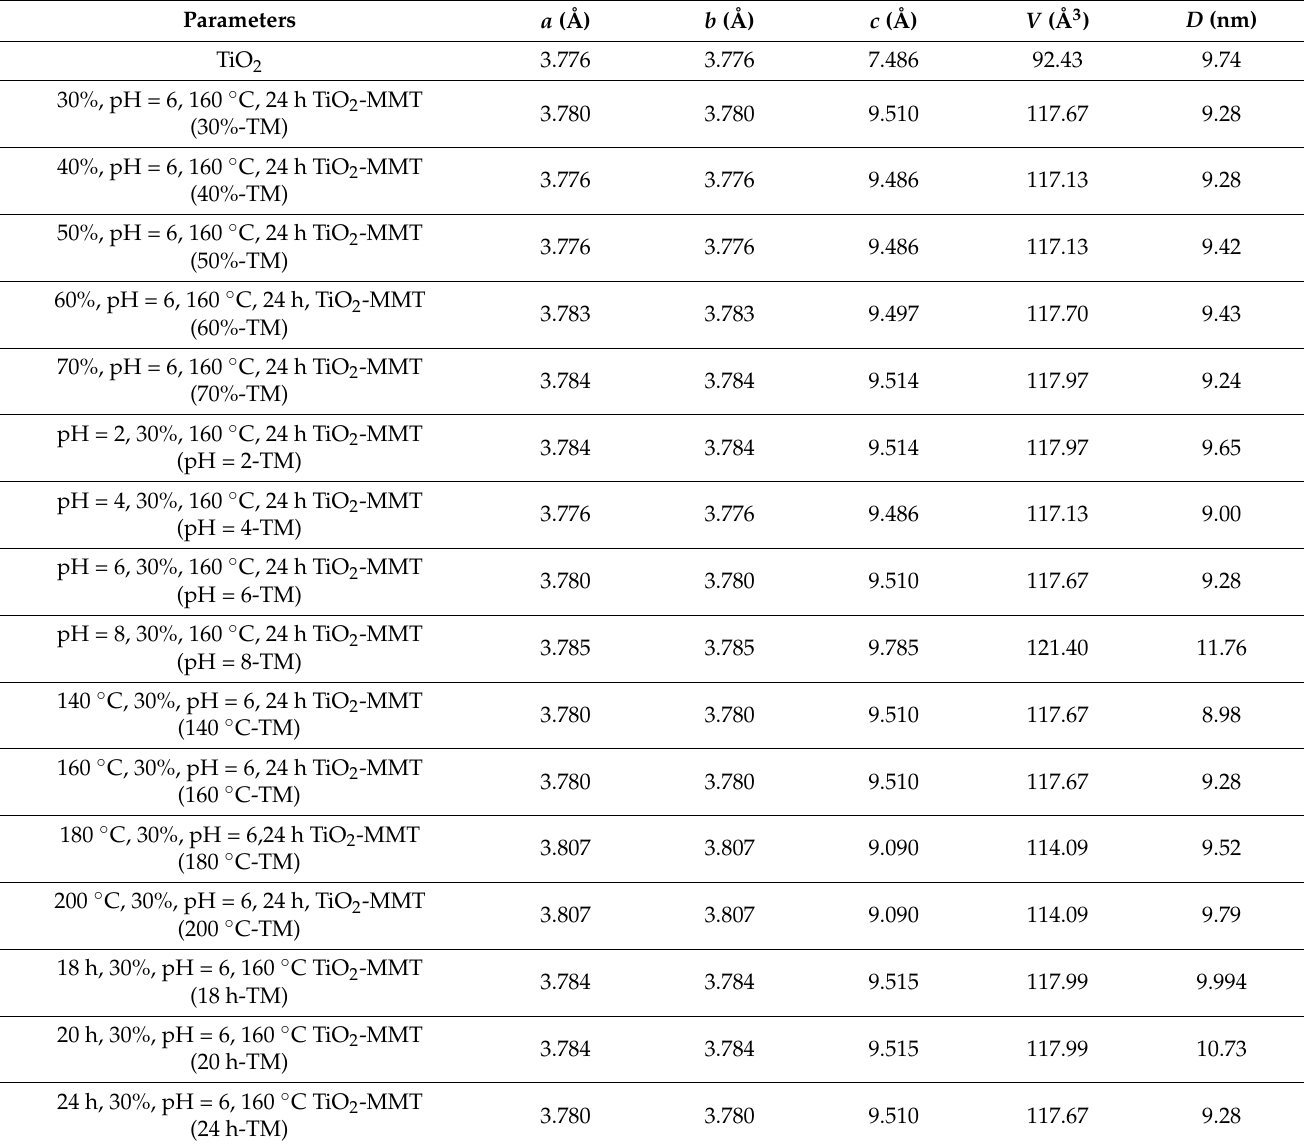
Table 1. Selected structural parameters of the prepared composites and the TiO2 reference ( a = b (cid:54) = c , α = β = θ = 90 ◦